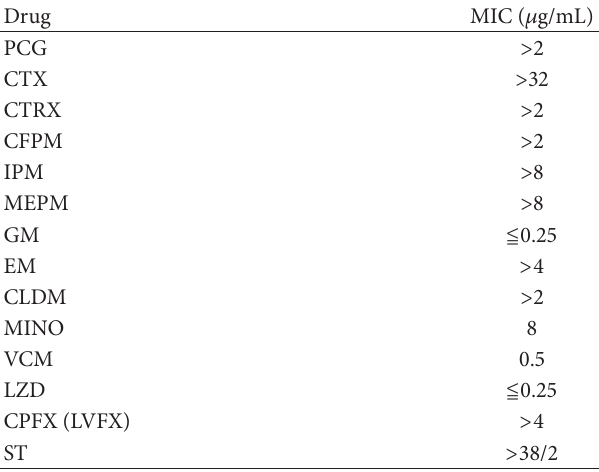
Table 1: Minimum Inhibitory Concentration of the C. striatum